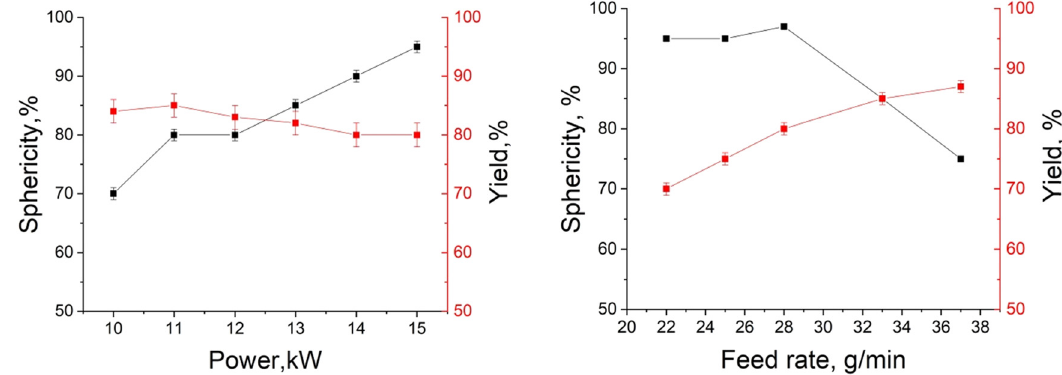
Figure 5: The dependence of the sphericity and the percentage yield of the powder on the power ( left ) and feed rate ( right ) .